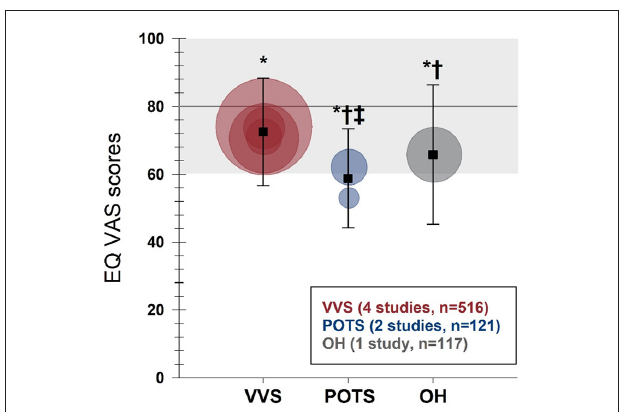
FIGURE 4 | Meta-analysis of EQ VAS in patients with VVS, POTS, and OH compared to United States normative data. EQ VAS scores are shown for patients with VVS (30, 31, 33, 34), POTS (48, 49) and OH (54). Circles represent mean scores from individual studies, with the size of the circle proportional to the study sample size. Weighted means and standard deviations for combined data for patients with VVS, POTS, and OH are indicated with black squares. Horizontal line and gray shading denote the mean and standard deviation based on US normative data ( n = 38,678) ( 59). *Significantly different to US normative data at the 0.001 level of significance. † Significantly different to the VVS group, at the 0.001 level of significance. ‡ Significantly different to the OH group, at the 0.01 level of